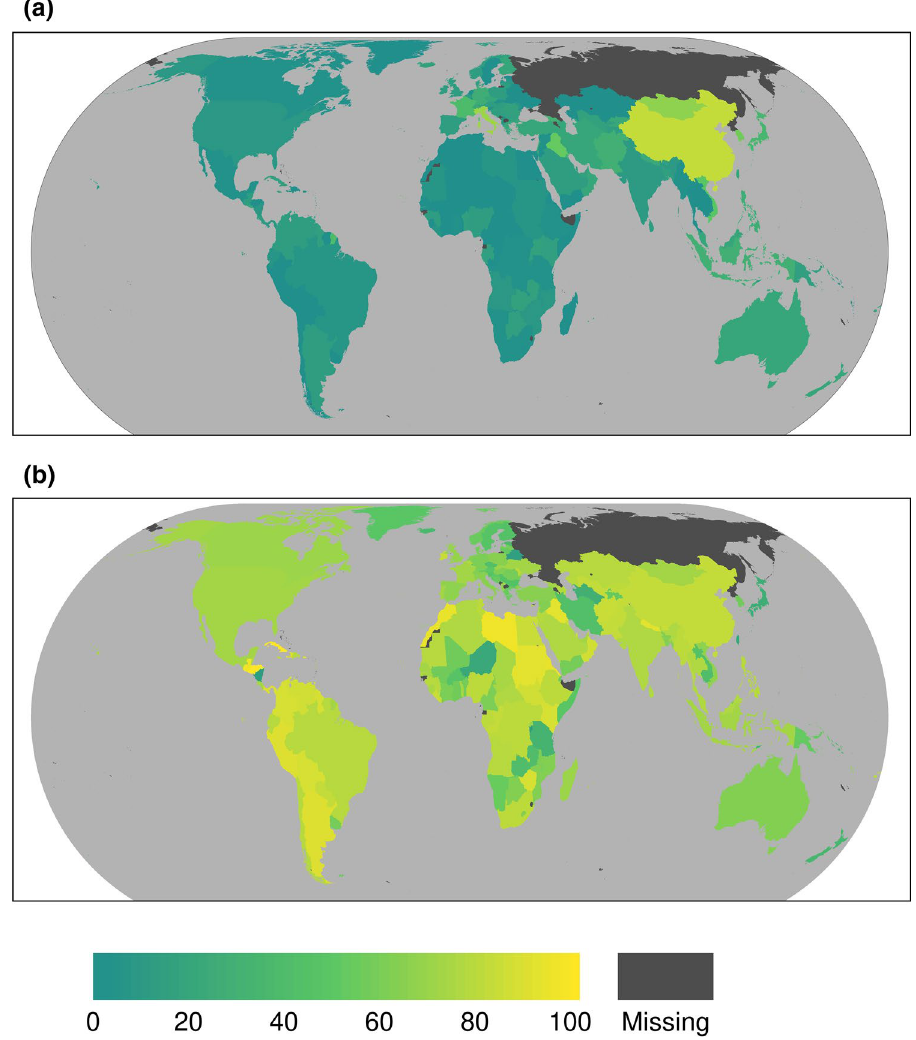
Fig. 2 Country-level COVID- 19 GRSI for a 1 March 2020 and b 1 June 2020. The index displays the degree of lock- down due to the COVID-19